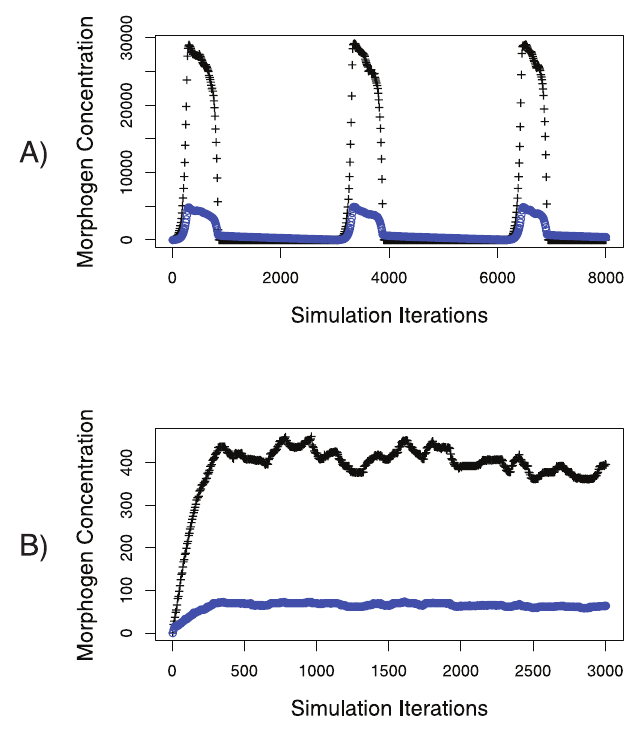
Figure 6. Dynamics of Oscillatory and Stationary Regimes (A) Oscillatory regime produces transient patterns that repeat over time but are spatially stochastic. (B) Stationary regime produces stable patterns with minor stochastic fluctuations around an equilibrium concentration. Graphs show the maximum concentration value for a single pixel across the entire molecular grid (that pixel lies within an activator peak as in Figure 3D but may shift from peak to peak as concentrations vary) for activator (black) and inhibitor (blue) morphogens.